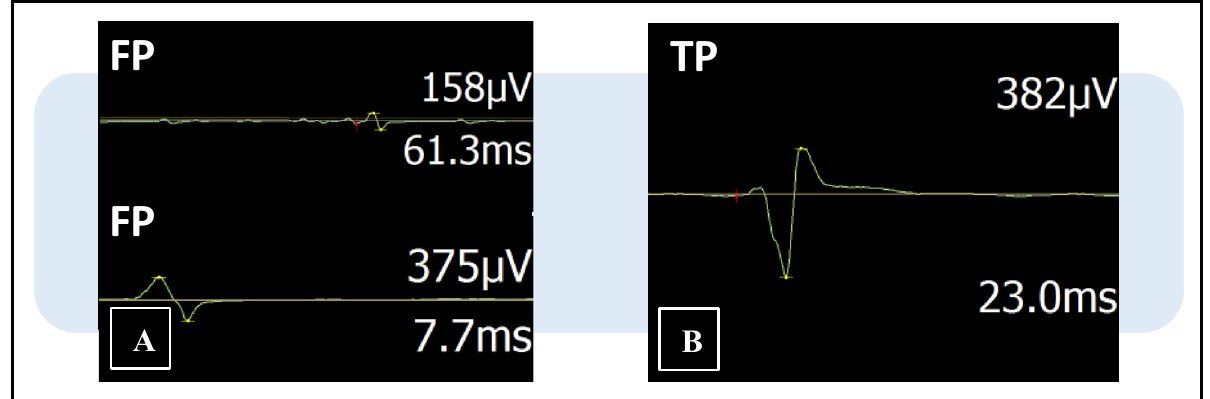
Figure 3. Examples of three motor evoked potentials (MEPs) displayed in the nTMS integrated EMG system with trace line, amplitude and latency values. The machine cannot recognize false-positive responses, which are instead erroneously considered eloquent points. ( A ) False-positive MEPs (FP) of correct amplitude (>50 μ V) but incorrect latency and shape. ( B ) True-positive MEP (TP) with regular shape, amplitude and latency value.